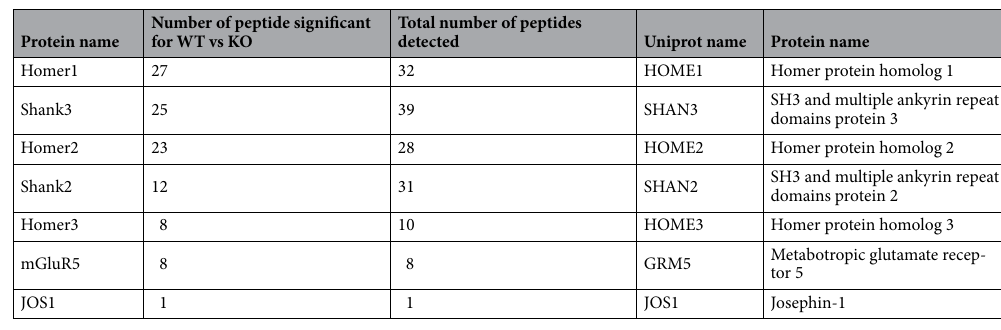
Table 1. Homer-interacting proteins identified by mass spectrometry.